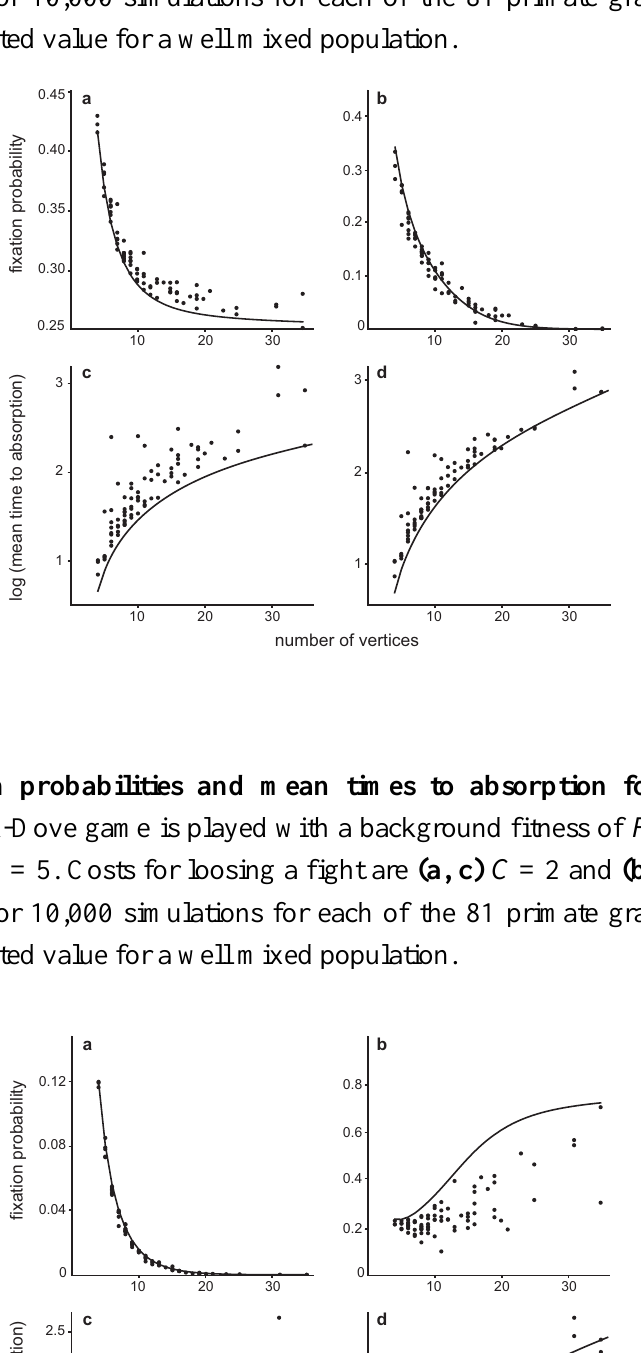
Figure 3. Fixation probabilities and mean times to absorption for a single Hawk = 5 and a value invader. The Hawk-Dove game is played with a background fitness of F B of the resource of B = 5. Costs for loosing a fight are (a, c) C = 2 and (b, d) C = 13. Dots give mean values for 10,000 simulations for each of the 81 primate graphs and the solid line gives the expected value for a well mixed population. 0.4